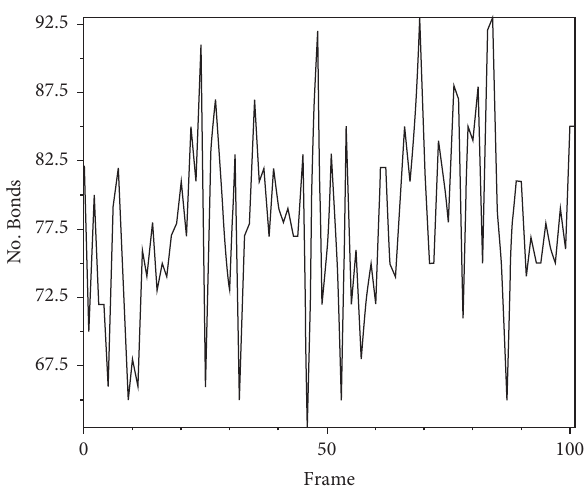
Figure 10: Assessment of RMSD plot during 10ns MD simulation. *e SRAS-CoV-2 Mpro backbone has been represented in red, the ligand ZINC000072307130 in gray, the complex in yellow, and the entire system in blue. *e RMSD plot ascertains the stability of the ligand, viral protein, and complex because of the extremely low RMSD values and insignificant structural